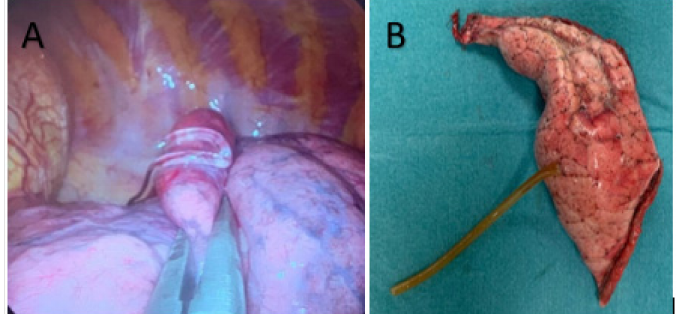
Figure 3. ( A ) Hydrogel plug sealed into lung parenchyma (uniVATS vision). ( B ) Lung specimen with hydrogel plug previously deployed (1 month before surgery).